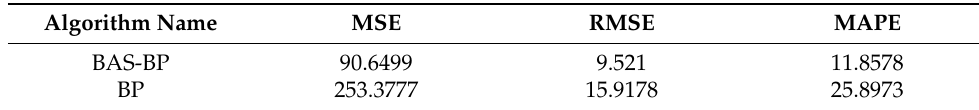
Figure 17. Fitting results of the training set of BAS-BP neural network. Table 1. Effect comparison of different